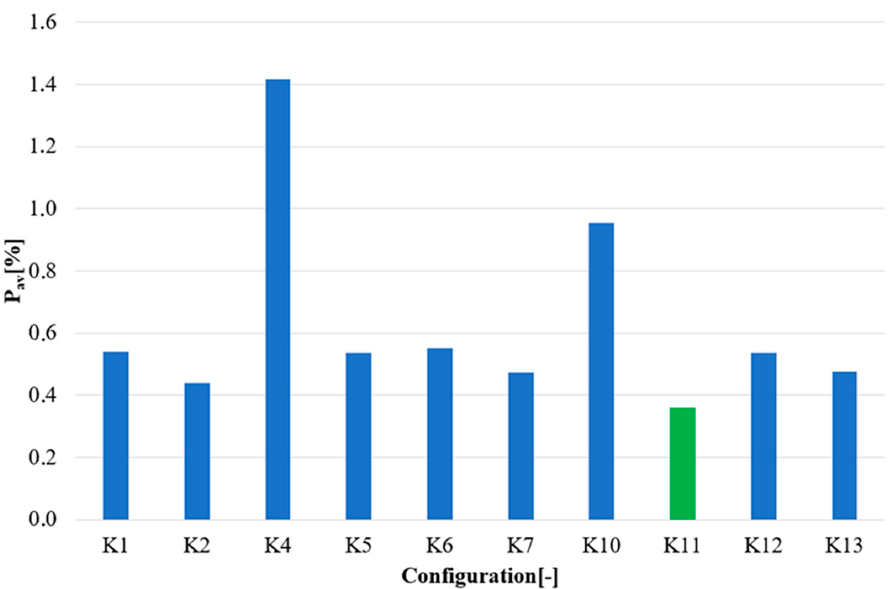
Figure 11. Average values of the number of data packets lost for each of the tested configurations (without configurations 3, 8 and 9).